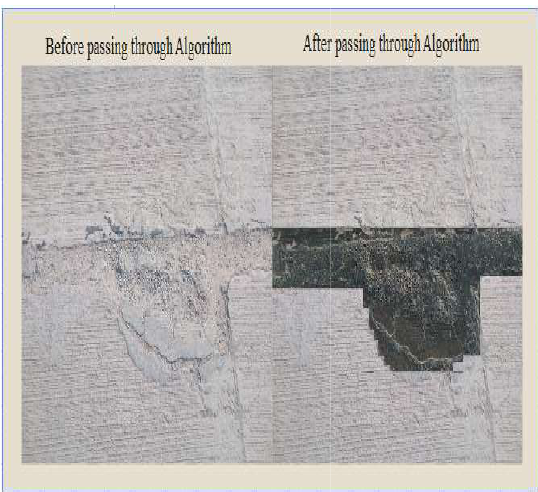
Figure 10 . Road section after passing through